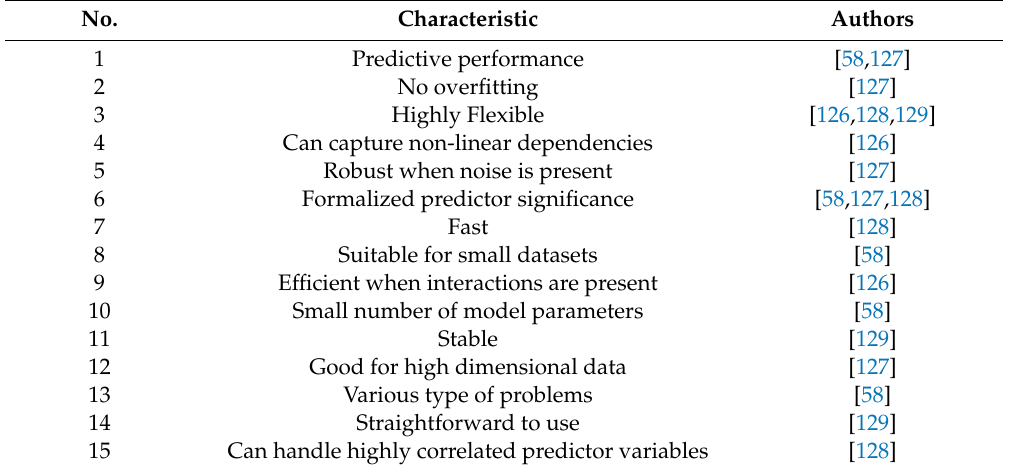
Table 2. Reasons for Random Forest use in the present